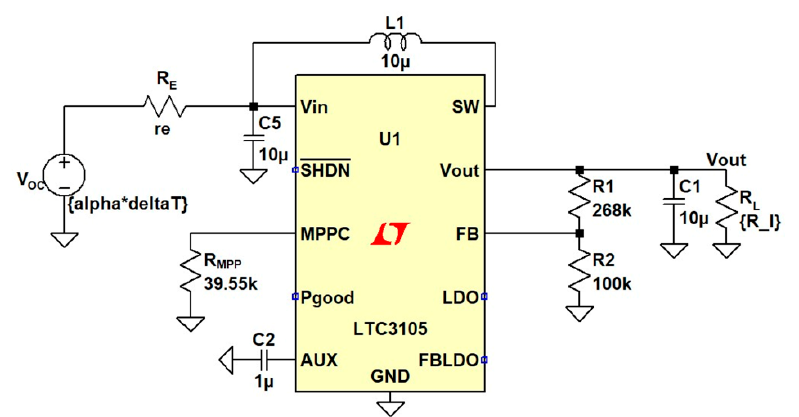
Figure 16. LTC-3105 Spice testbench.